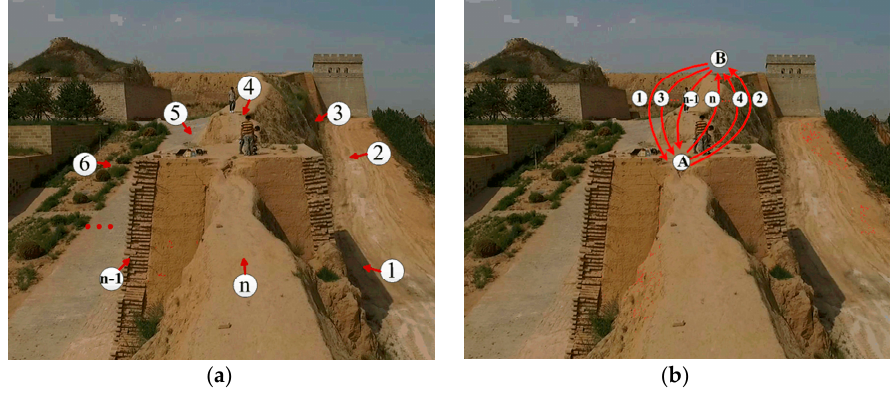
Figure 2. Different scan modes for two typical Great Wall segments (Zhenbei Tai, Yulin, Shannxi Province, China) ( a ) fly ‐ hover ‐ scan mode; ( b ) flying ‐ scan mode.